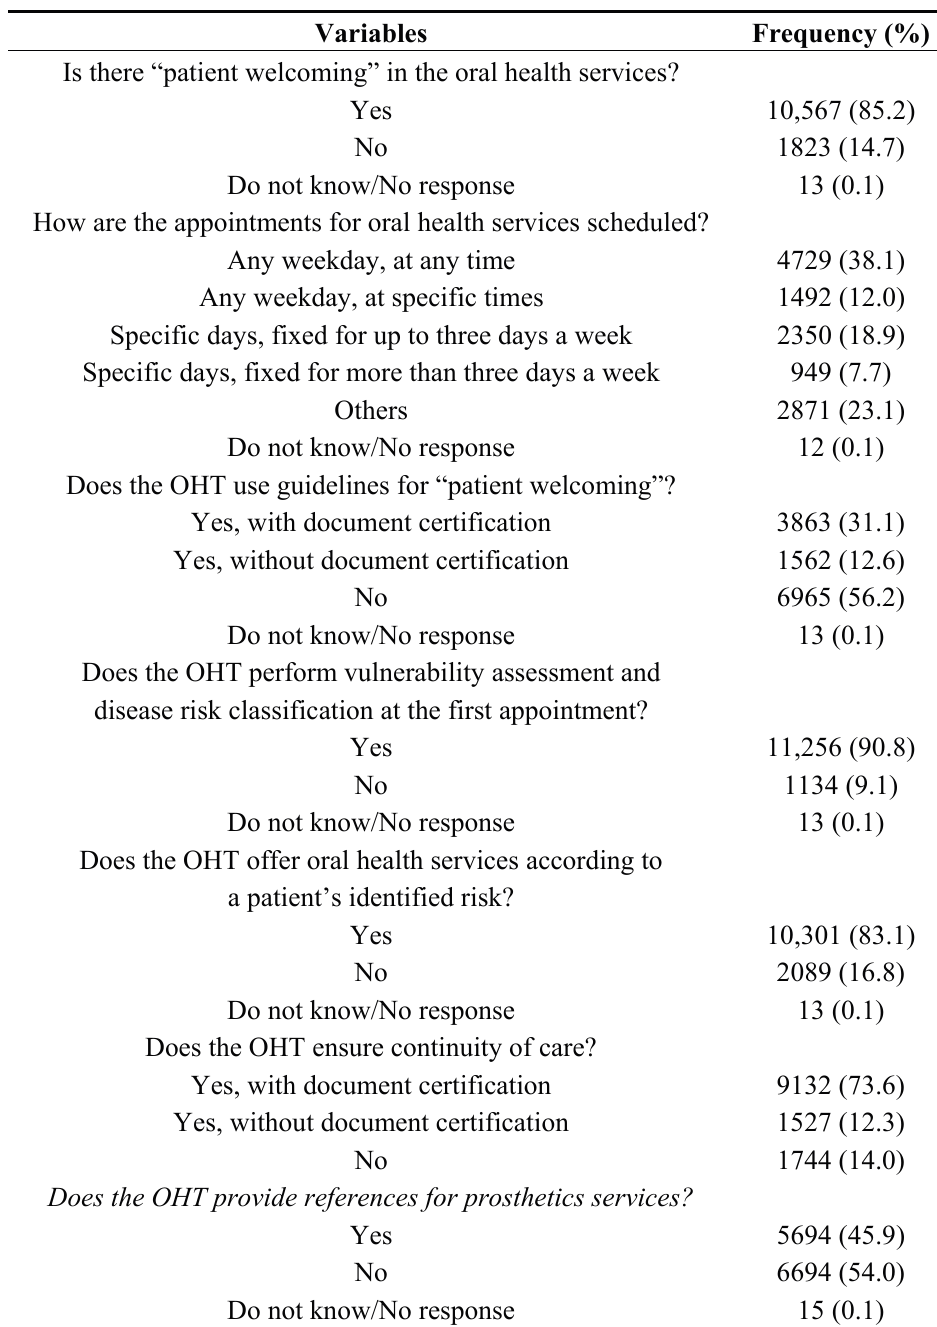
Table 1. Actions performed by oral health teams related to access to care, health service organization, and continuity of care in Brazil,